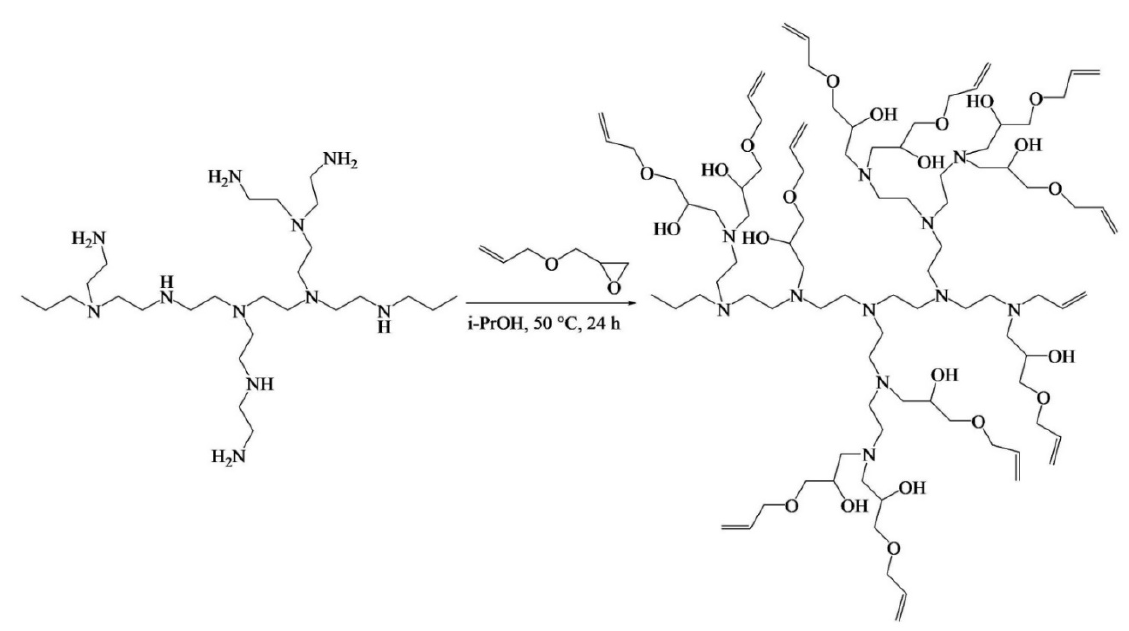
Figure 24. Synthetic route of allyl-terminated hyperbranched polyethyleneimine (PEIene) as depicted by Acebo et al. Adapted with permission from [66]; published by Elsevier, 2016.